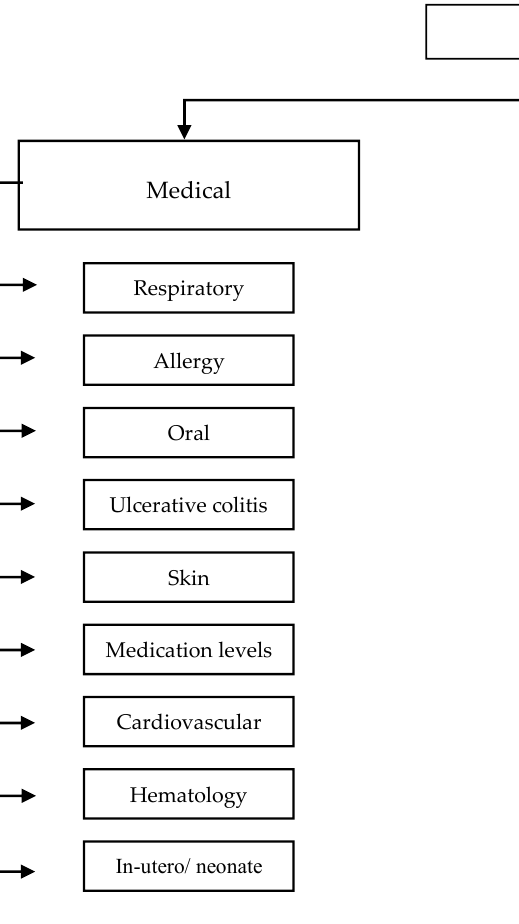
Figure 2. Classification by type of injury of e-cigarette-related case reports.